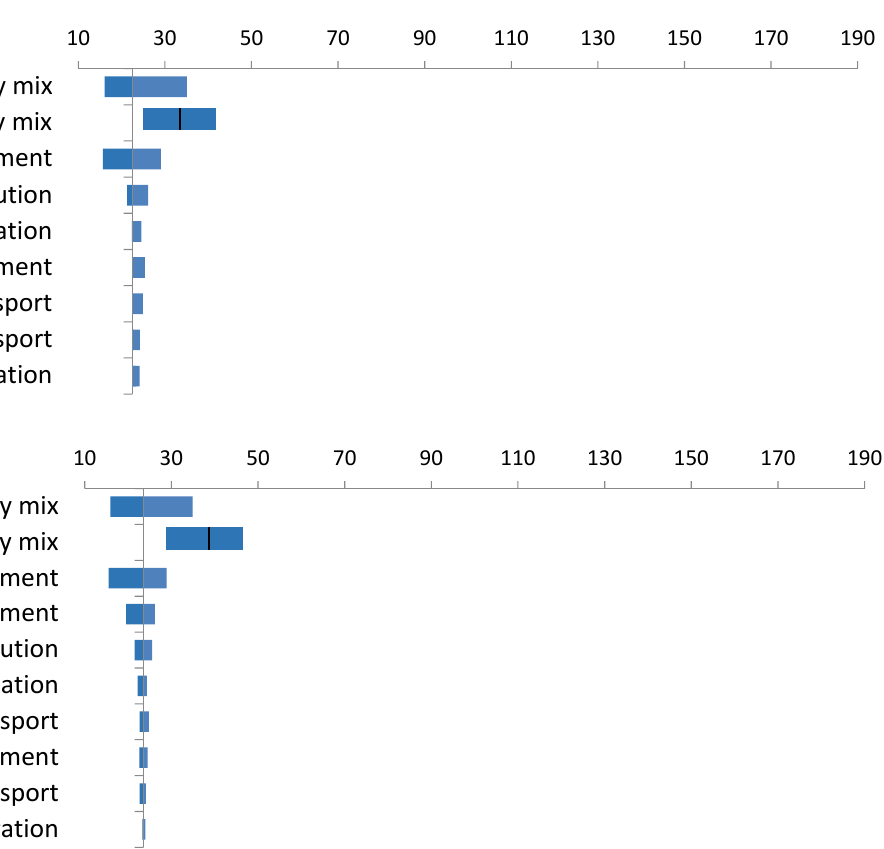
Figure 5. Sensitivity analysis of global warming potential of water systems. Vertical lines represent the base case for each system. The bars demonstrate the variation associated with the following changes in the parameters listed at the left: carbon intensity, electricity produced from co-digestion, pump and motor efficiencies, flow rate, electricity input in water treatment plant, electricity input in wastewater treatment plant, UV dose. The ranges of each variable are identified in Table 1.